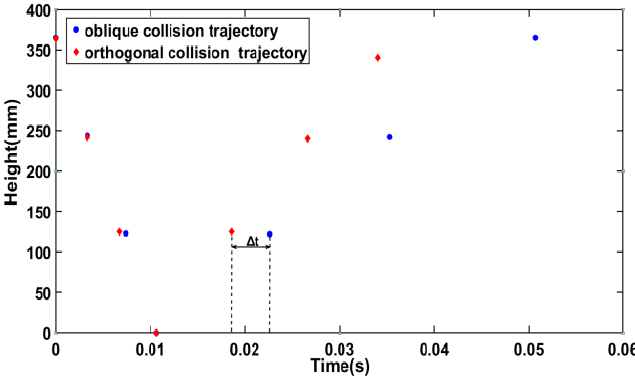
Figure 8. Grain movement trajectory .